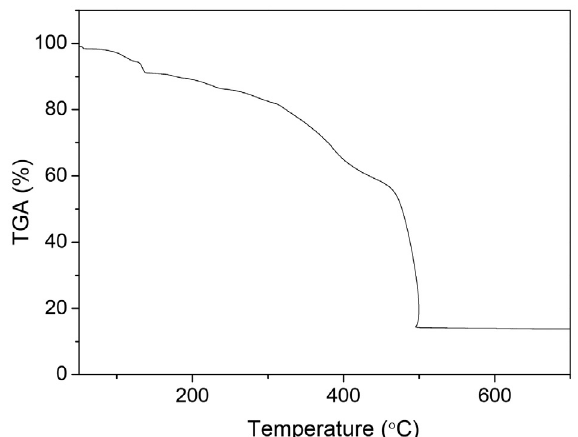
Figure 8. The TGA thermogram of complex 2 in air